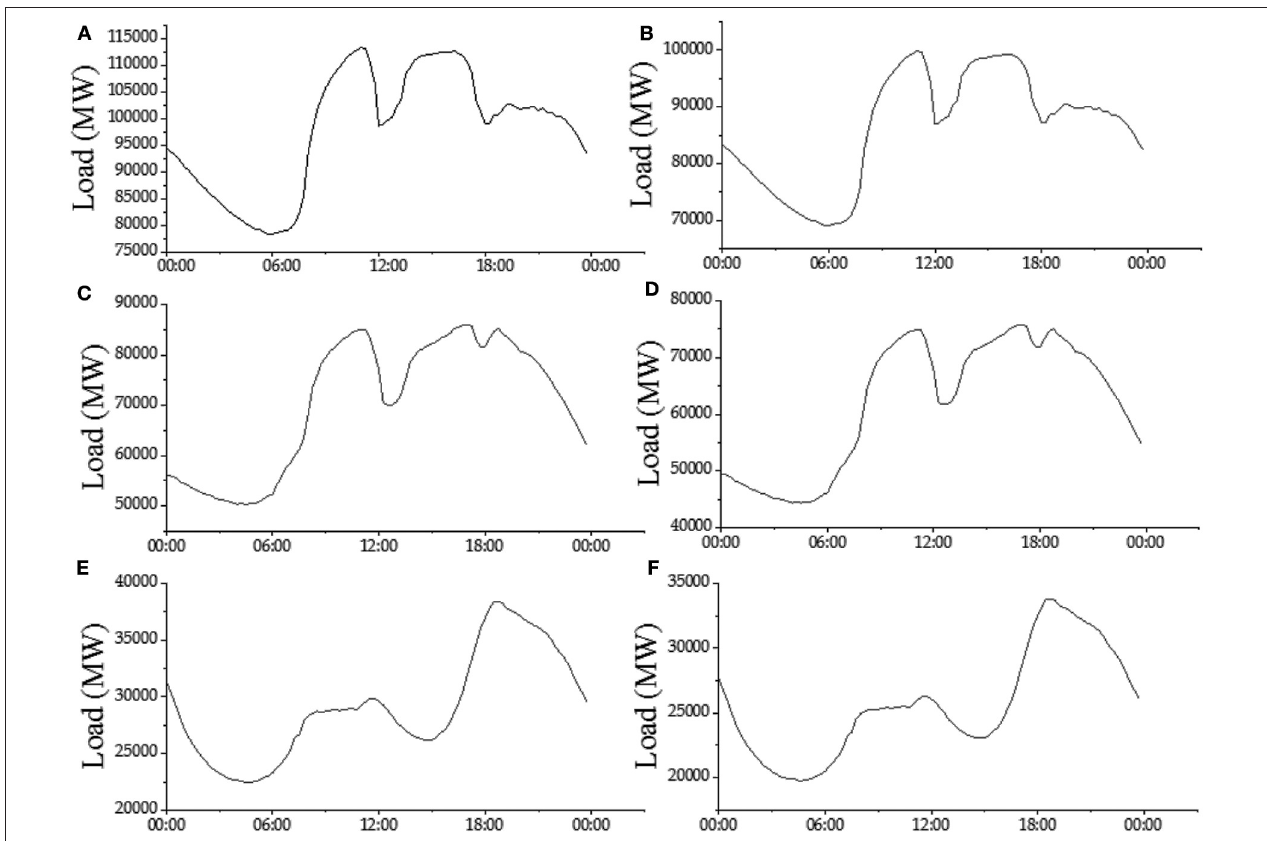
FIGURE 3 | Typical daily load curve of Guangdong in 2017. (A) Weekdays in winter. (B) Weekends in winter. (C) Weekdays in spring and autumn. (D) Weekends in spring and autumn. (E) Weekdays in summer. (F) Weekends in summer.